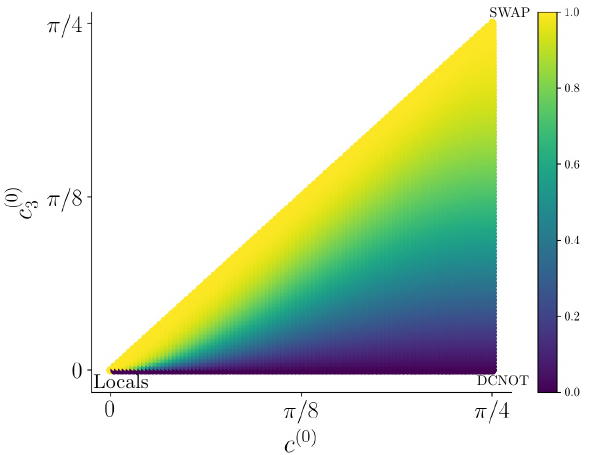
FIG. 5. Convergence in the XXZ case: the initial condition in the local- SWAP - DCNOT face. r = sin ( 2 c ( 100 ) which is related to the rate of convergence to a dual-unitary gate as ξ = ln r , is plotted. Around 10 5 initial conditions ( c ( 0 ) , c ( 0 ) are taken and evolved for n = 100 times under the 2D map given in Eqs. (55)–(56). Initial conditions with c ( 0 ) the triangle above, converge to the DCNOT gate at an infinite rate, while initial conditions with c ( 0 ) = c ( 0 ) the SWAP gate at a vanishing rate, namely